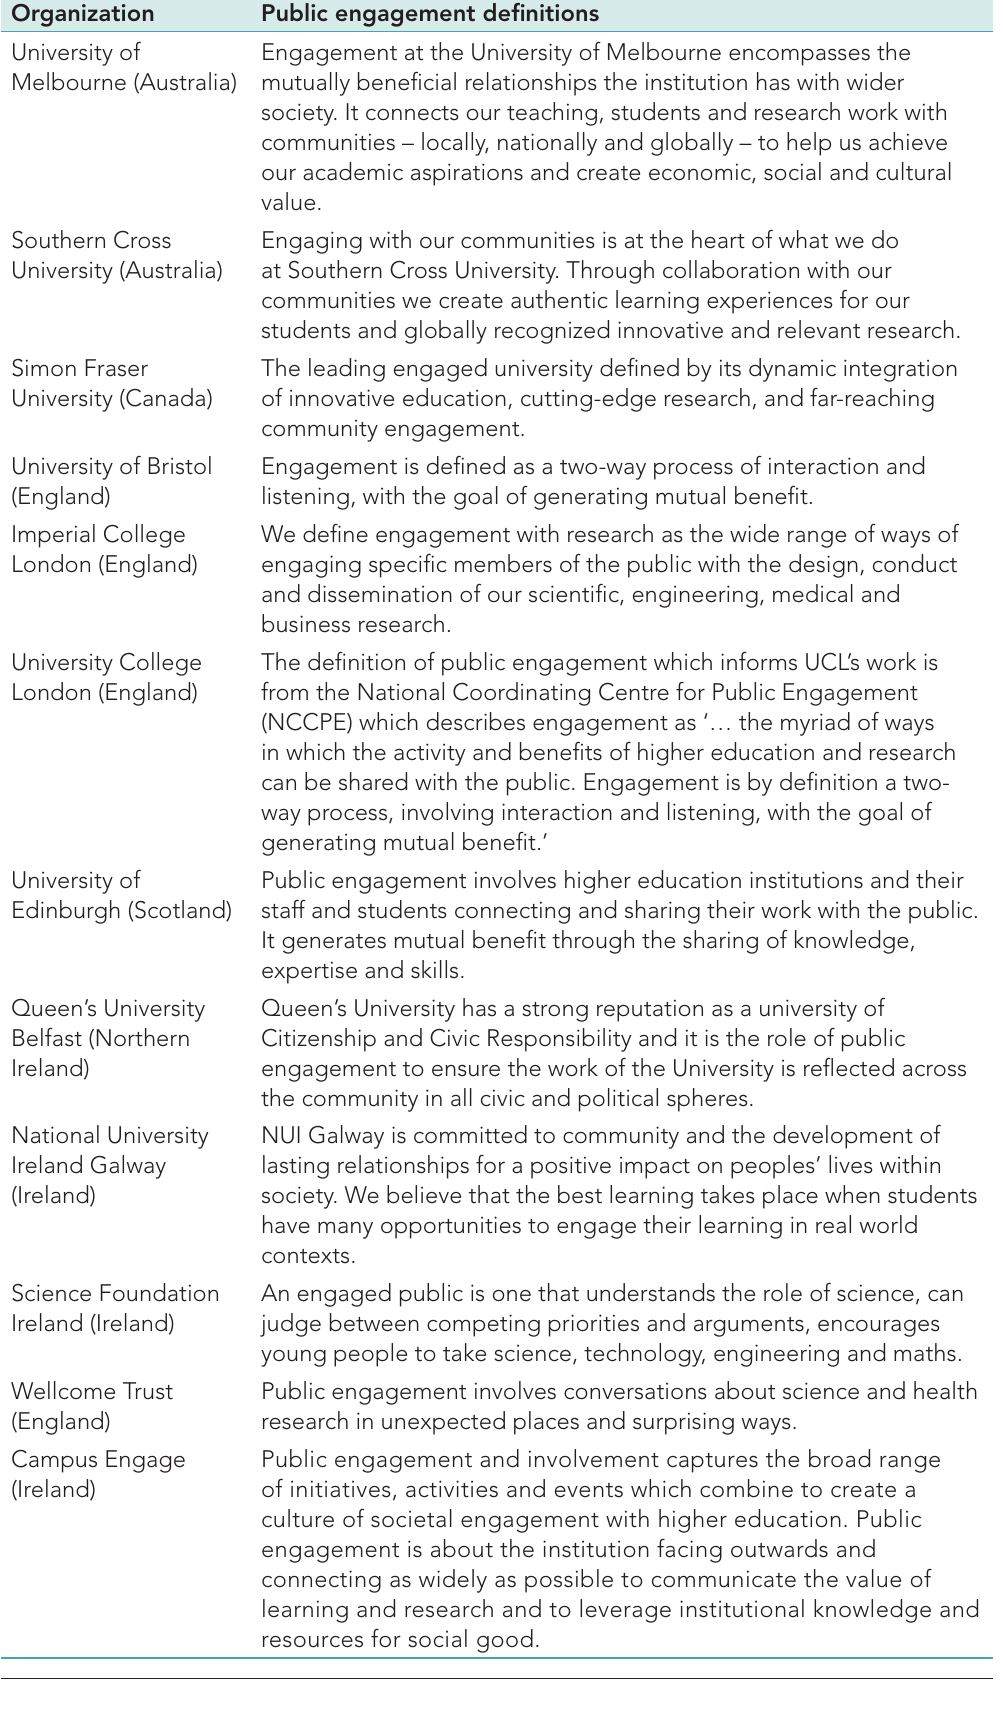
Table 1: examples of public engagement definitions from selected universities and organizations (sources: organization